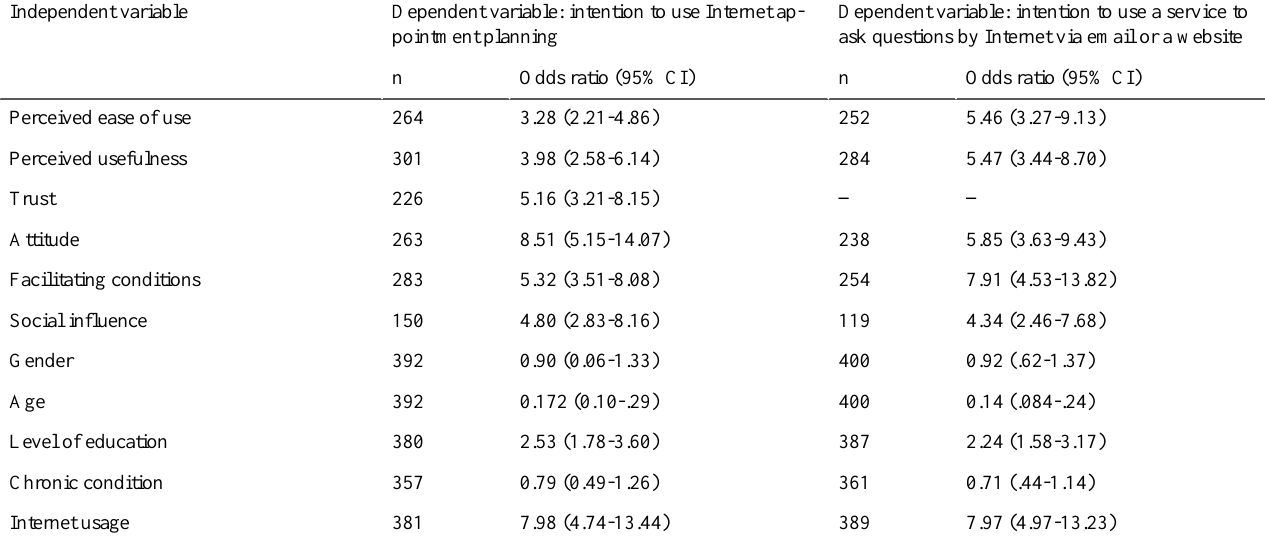
Table 4. Univariate association of constructs and characteristics with intention toward using Internet appointment planning and asking questions by Internet via email or a website. All constructs and characteristics had a significant association with intention to use both services, except for gender and chronic